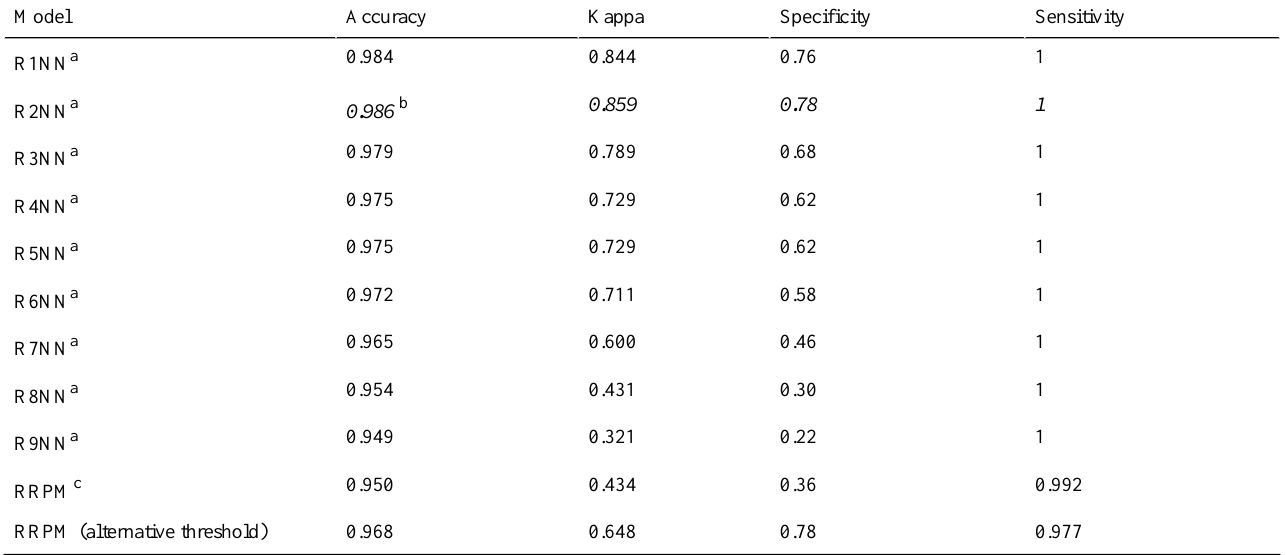
Table 7. Performance of the classification